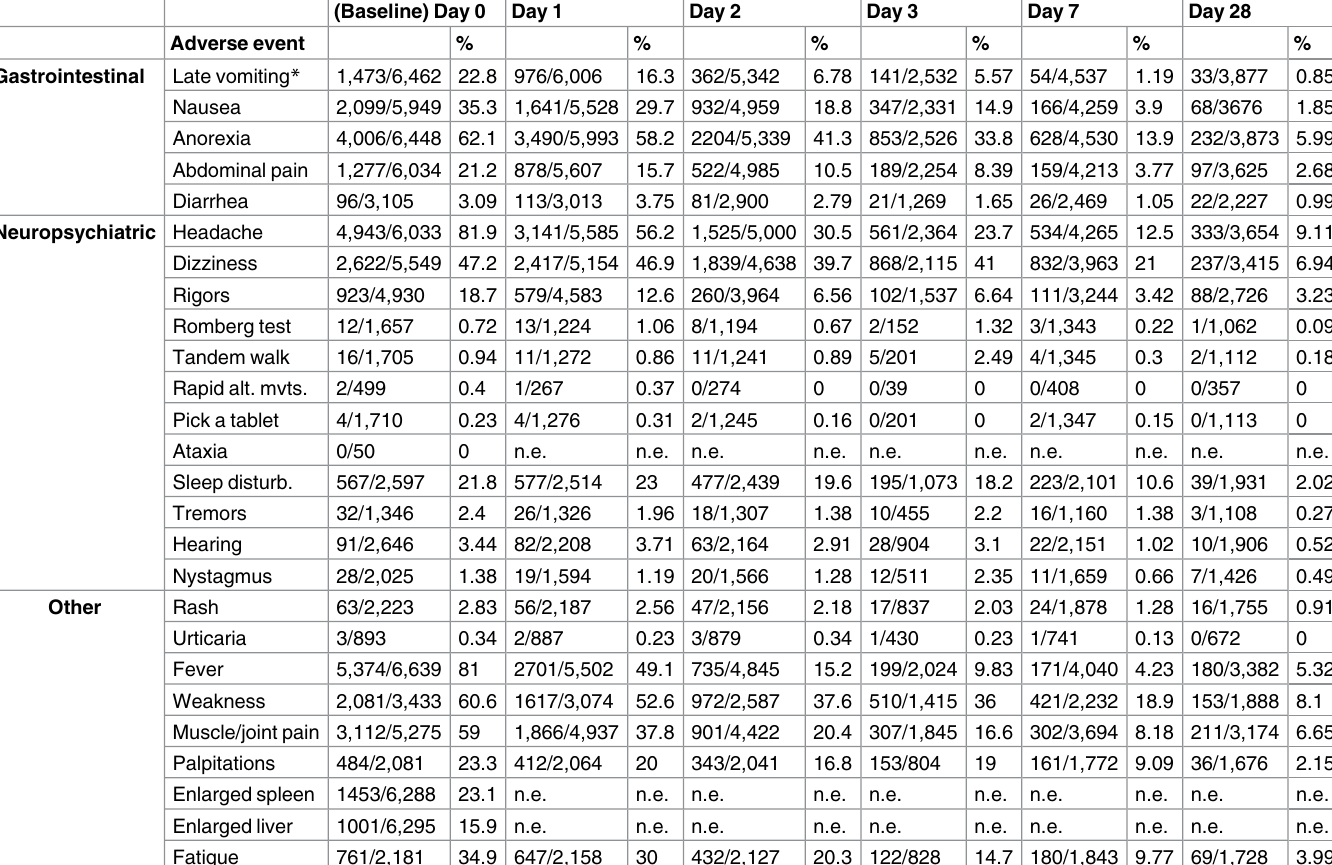
Table 3. Frequency of